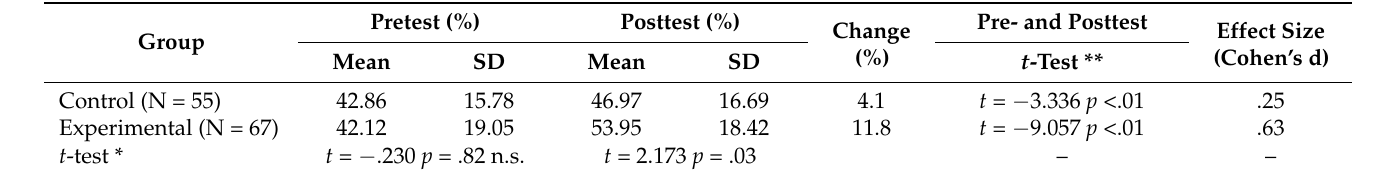
Table 6. Changes in the achievements of the control and the experimental group between the pre- and